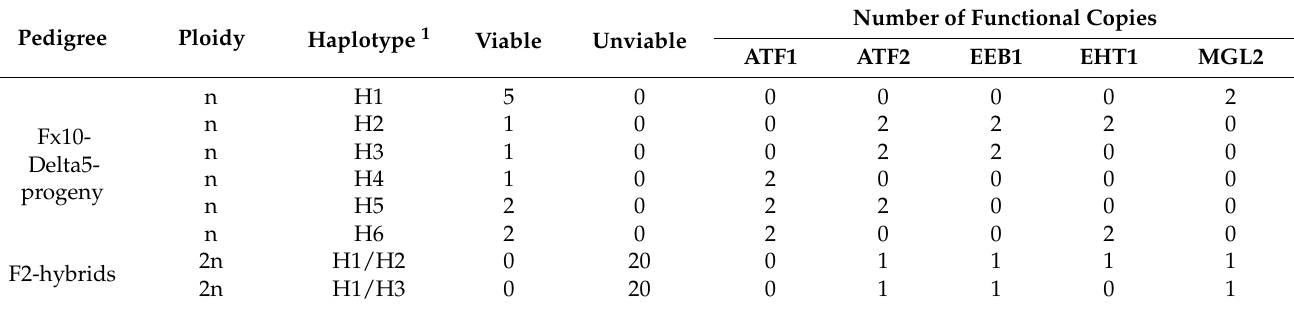
Figure 5. Genetic interactions between esterase genes impair the development of a multiple deletion strain. ( a ) Observed (light blue) and expected (dark blue) occurrences of meiotic progeny of the Fx10- Δ AEM ( ATF1/ Δ atf1 , ATF2/ Δ atf2 , EEB1/ Δ eeb1 , EHT1/ Δ eht1 , MGL2/ Δ mgl2 ) harboring 0 to 5 knocked-out genes. ( b ) Frequencies of meiotic segregants of the hybrids H1xH5 and H1xH6 showing a double deletion for the genes ATF1 , ATF1 , EEB1 , EHT1 , and MGL2 . Table 3. Summary of haplotypes